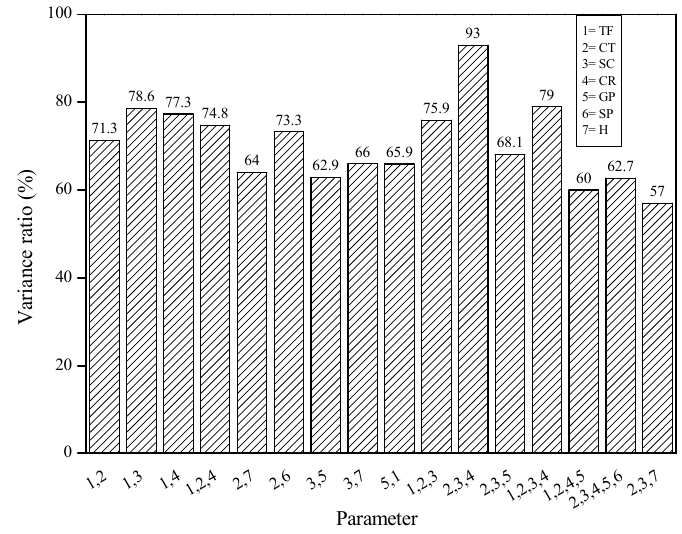
Figure 6. Principal components analysis for some parameters in this study.